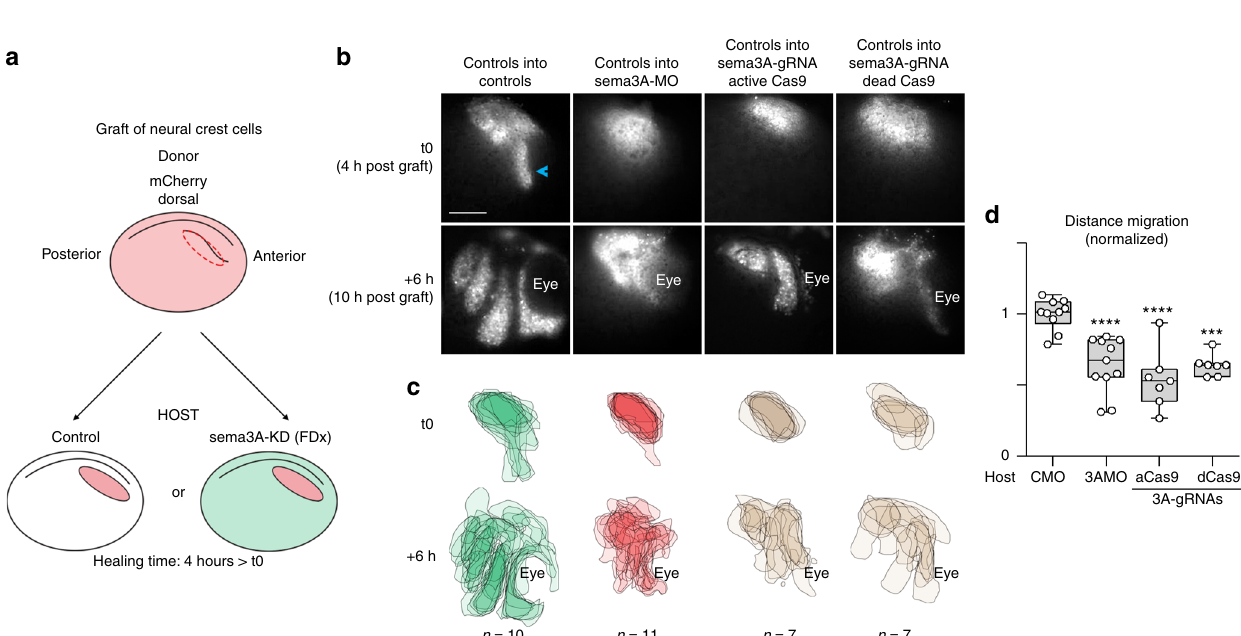
Fig. 2 Neural Crest migration in control and sema3A-KD environments. a Procedure for grafting of NC cells. b Images at t0h and t6h of the time lapse movies corresponding to 4 h and 10 h after the graft, respectively. c Projections of all NC domains at t0h and t6h for all experimental conditions, note that overall distribution and dorso-ventral migration of control NC cells are affected in sema-KD background. d Graph plotting the distance migrated by NC cells in all conditions shown in b , c . 35 embryos ( n CMO = 10, n Sema3AMO = 11, n Sema3A-gRNA-aCas9 = 7, n Sema3A-gRNA-dCas9 = 7), from fi ve independent experiments. ANOVA followed by multiple comparisons. **** p < 0.0001; *** p < 0.001. Scale bar 150 μ . Box and whiskers plot: the box extends from the 25th to the 75th percentile; the whiskers show the extent of the whole dataset. The median is plotted as a line inside the box. Source data are provided as a Source Data fi indicating a delay of the onset of migration. After 6 h of time- lapse (10 h post-graft), all NC cells are migrating dorso-ventrally but cells in sema-KD embryos have not reached ventral portions of the face (Fig. 2c) and there is a signi fi cant reduction of the total distance migrated (Fig. 2d).